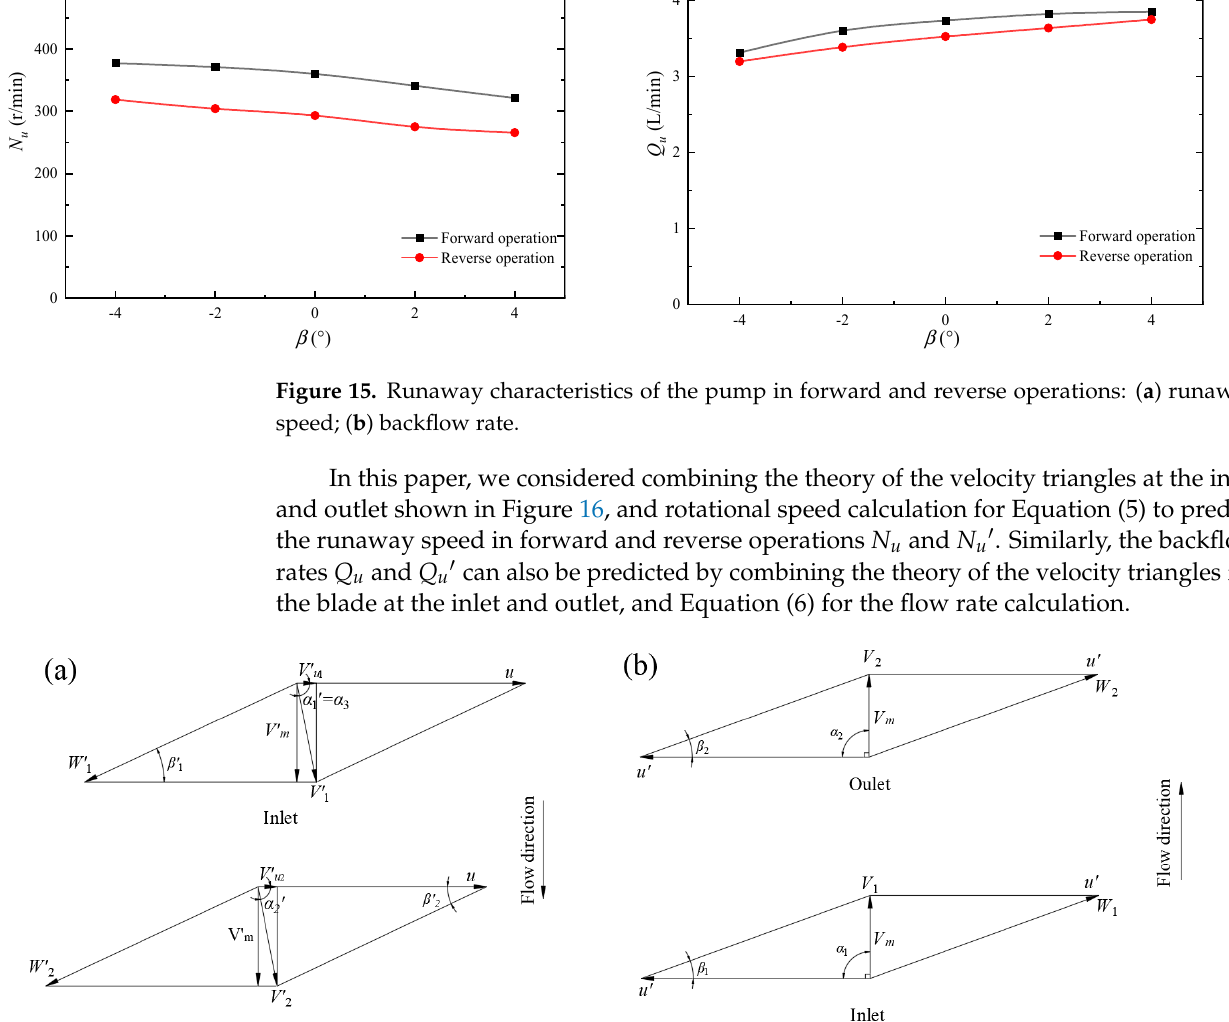
Figure 16. Velocity triangles for runaway state in: ( a ) forward operation; ( b ) reverse operation.